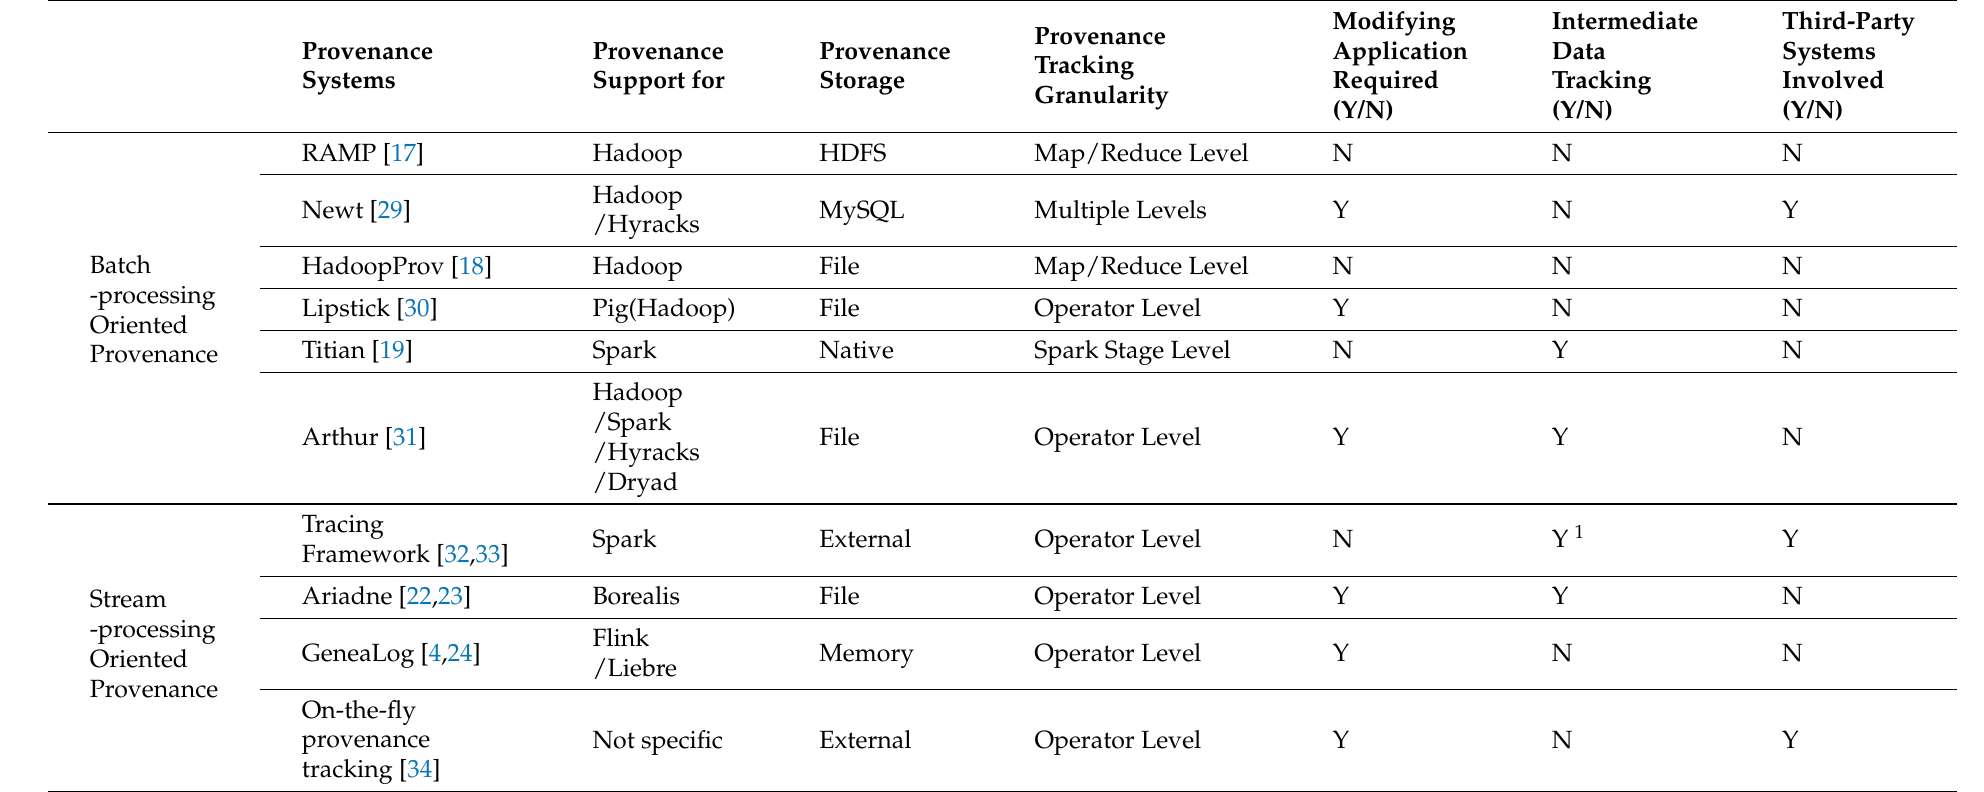
Table 1. Summary of features in general-purpose data processing systems with provenance